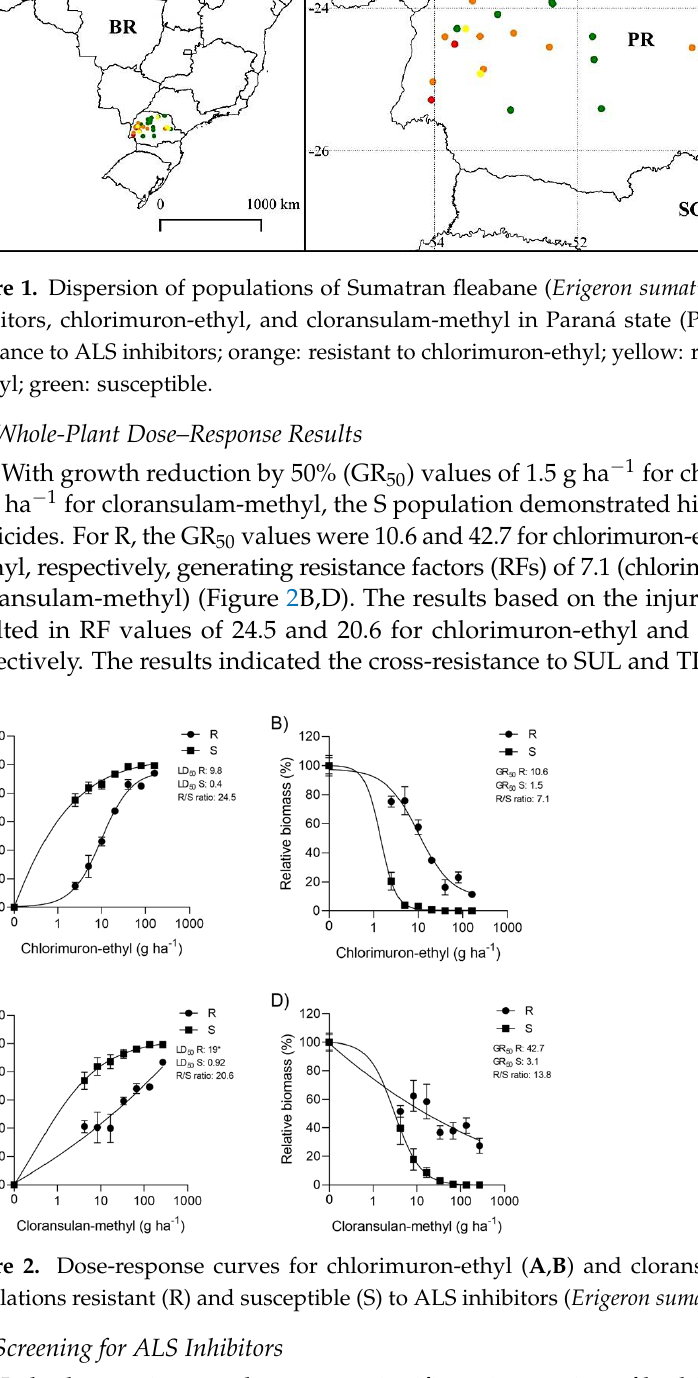
Table 1. Percentages of injury at 28 days after application (DAA) of two Erigeron sumatrensis pop- ulations after the application of ALS-inhibiting herbicides in Pre- and Post-emergence. Herbicide ( Dose in g ha −1 )